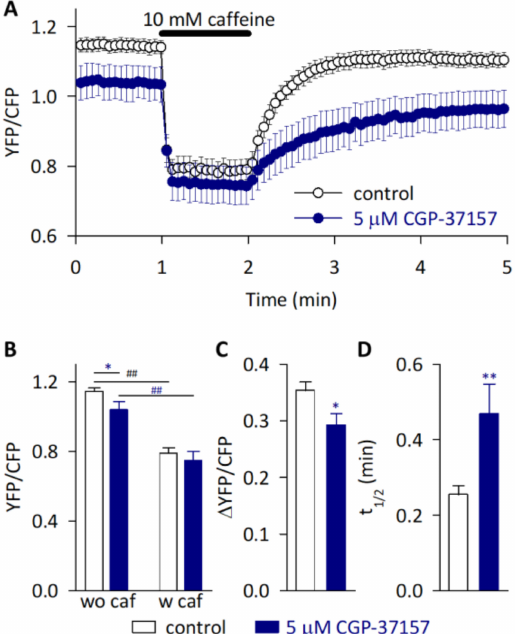
Figure 7. Effects of NCLX inhibition on the SR Ca 2+ dynamics in HL-1 cardiomyocytes. ( A ) The SR Ca 2+ , evaluated as Cameleon D1ER-derived YFP/CFP, was emptied by applying 10 mM caffeine for 1 min, then the recovery was assessed for 3 min in the absence (control; white circles) or presence (blue circles) of an NCLX blocker, 5 µ M CGP-37157. Data are expressed as mean ± s.e.m. of 8–12